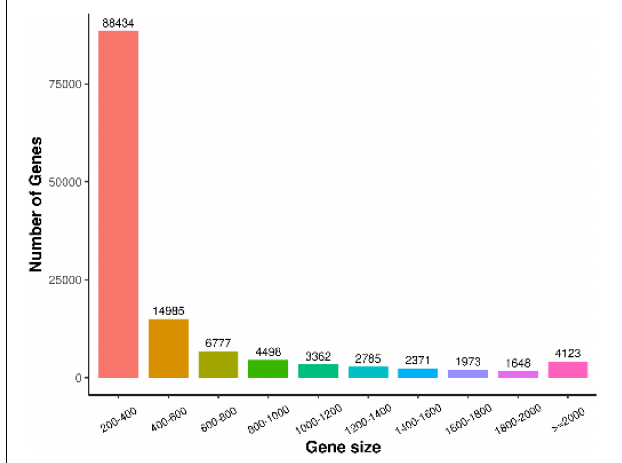
FIGURE 2 | Length distribution statistics of assembly results. X -axis represents the range of gene length, and Y -axis represents the number of gene lengths within this